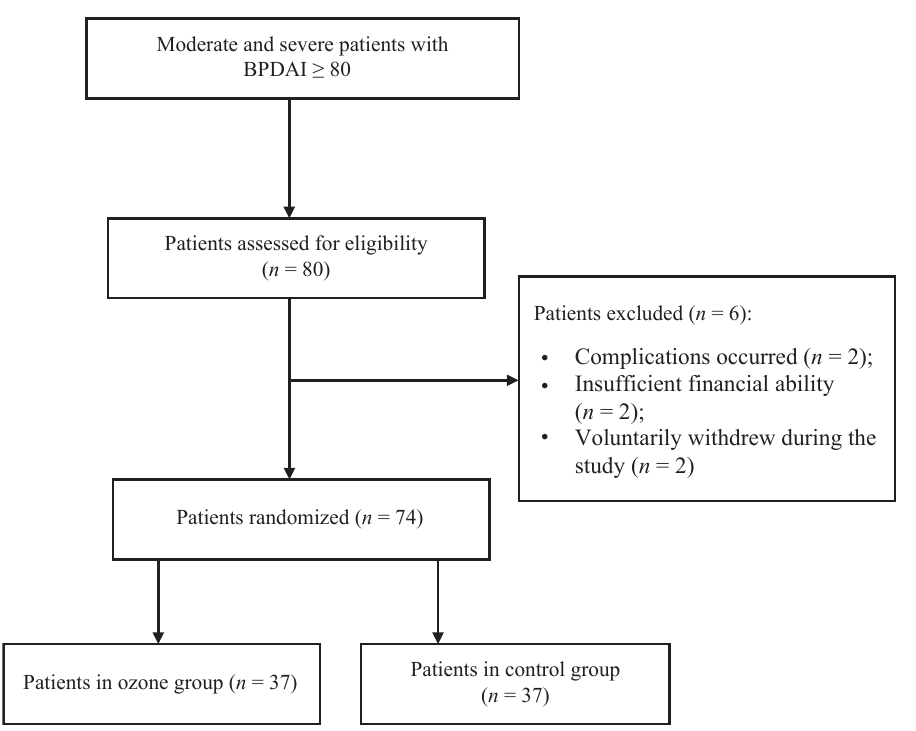
Table 1. Comparison of basic data between two groups of patients.